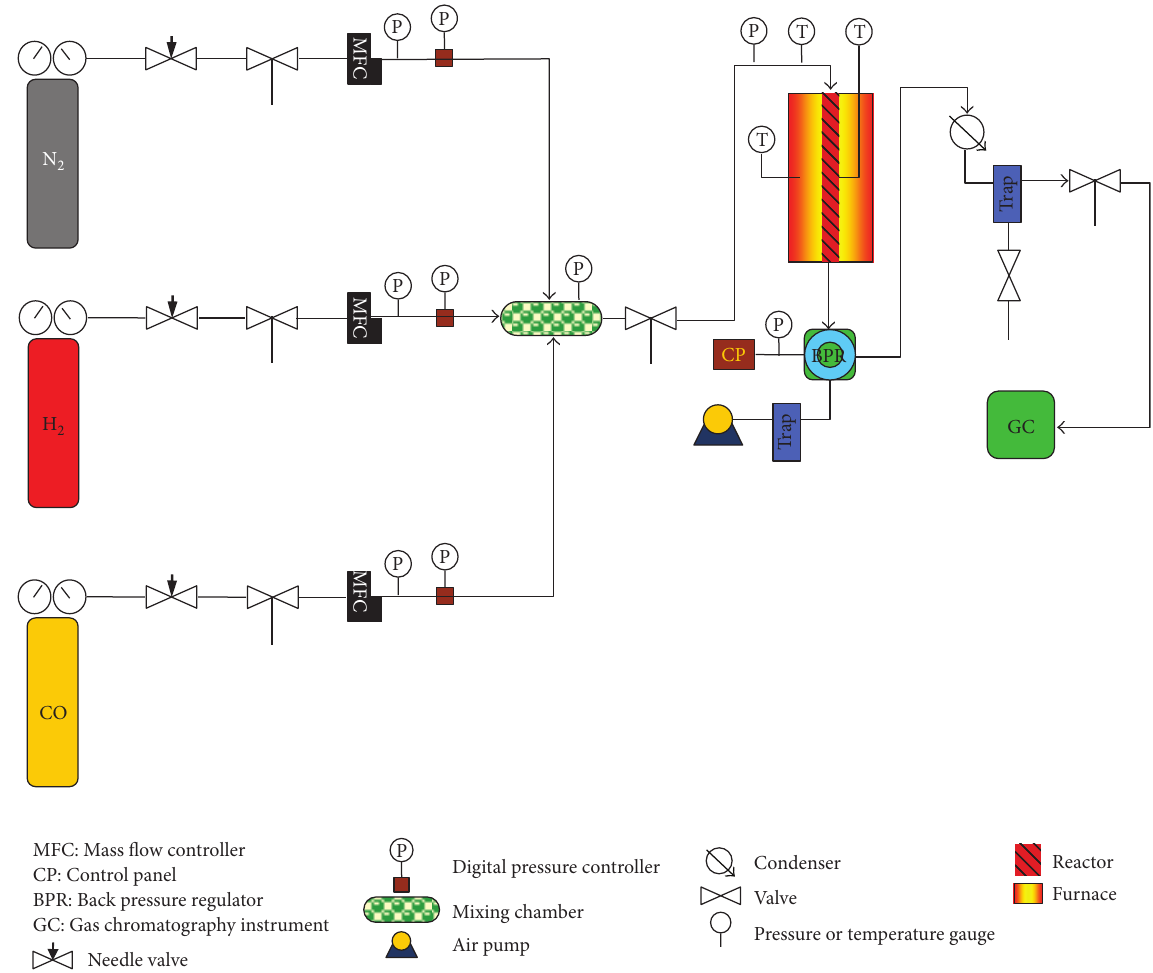
F 2: Schematic representation of the catalyst performance